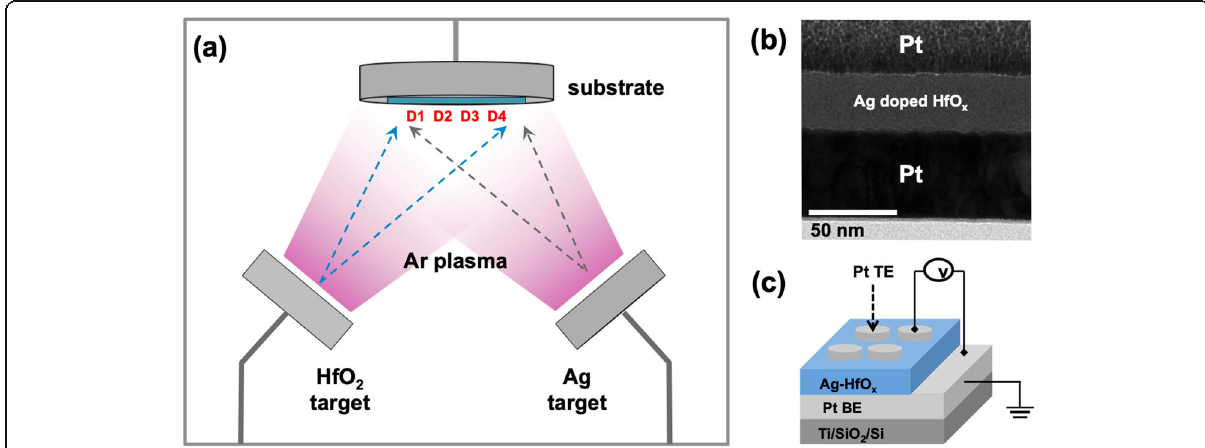
Fig. 1 a Schematic diagram of a co-sputtering system. b Cross-sectional TEM image of the fabricated device. c Schematic diagram of the device with the electrical measurement